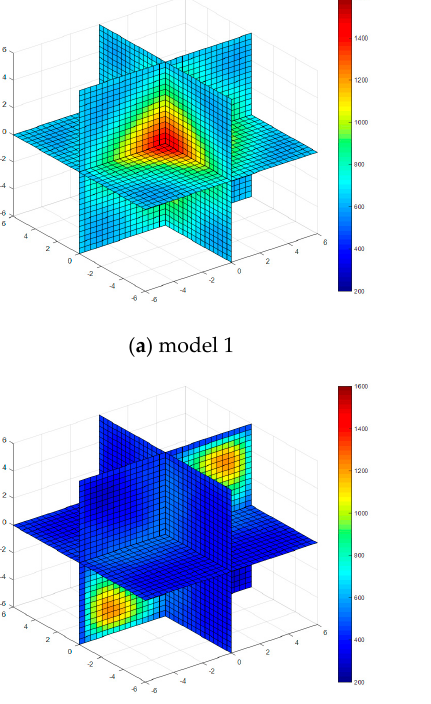
Figure 5. Diagram of reconstructed temperature fields by algebraic reconstruction technique (ART).